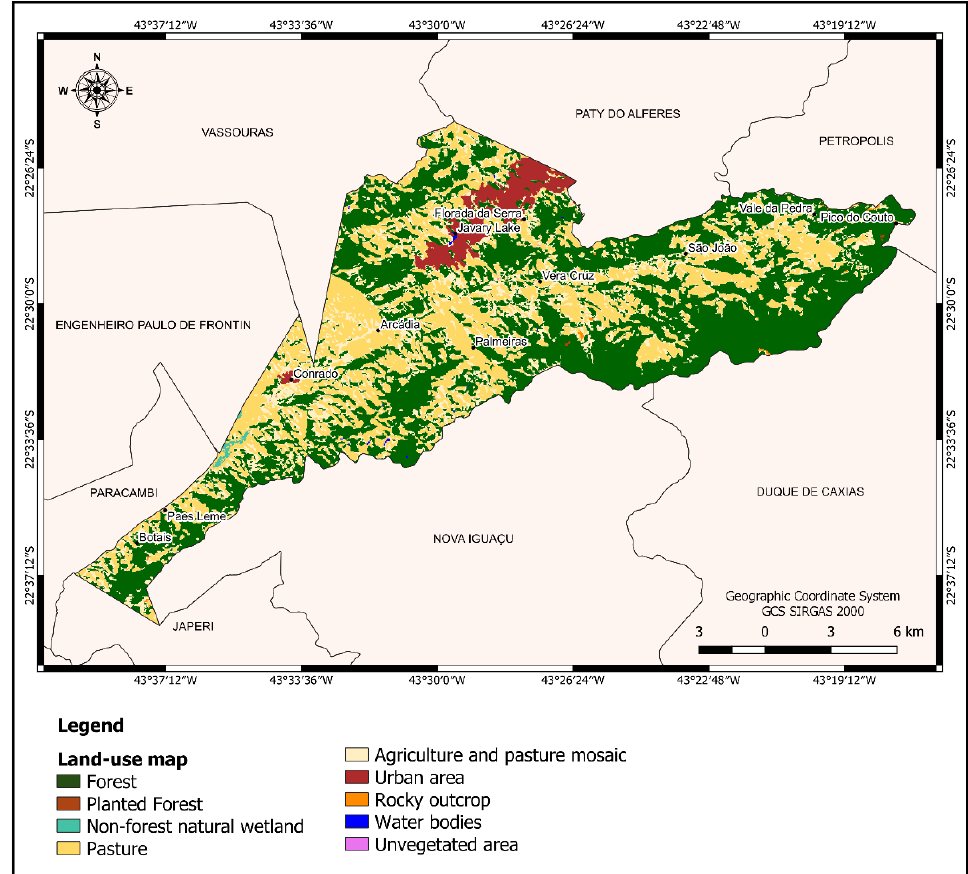
Figure 5. Land-use map of Miguel Pereira municipality, Rio de Janeiro State, Brazil [55].